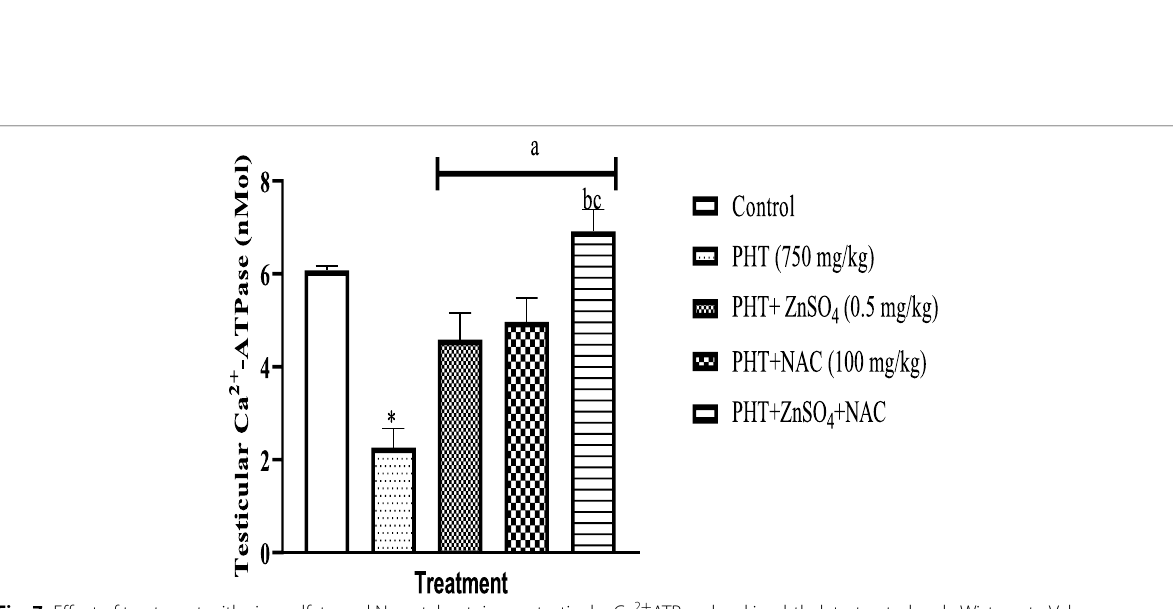
Fig. 6 Effect of zinc sulfate and N‑acetylcysteine on testicular inflammatory biomarker (TNF‑α) and anti‑apoptotic factor (BCL‑2) in phthalate‑induced reproductive toxicity in male Wistar rats. Values are expressed as mean hoc test). PHT phthalate, ZnSO 4 zinc sulfate, NAC N‑acetylcysteine. ⁕ , a , b , and c p < 0.05 statistically significant when compared with the control, PHT‑, PHT ZnSO 4 ‑, and PHT NAC‑treated groups respectively + +